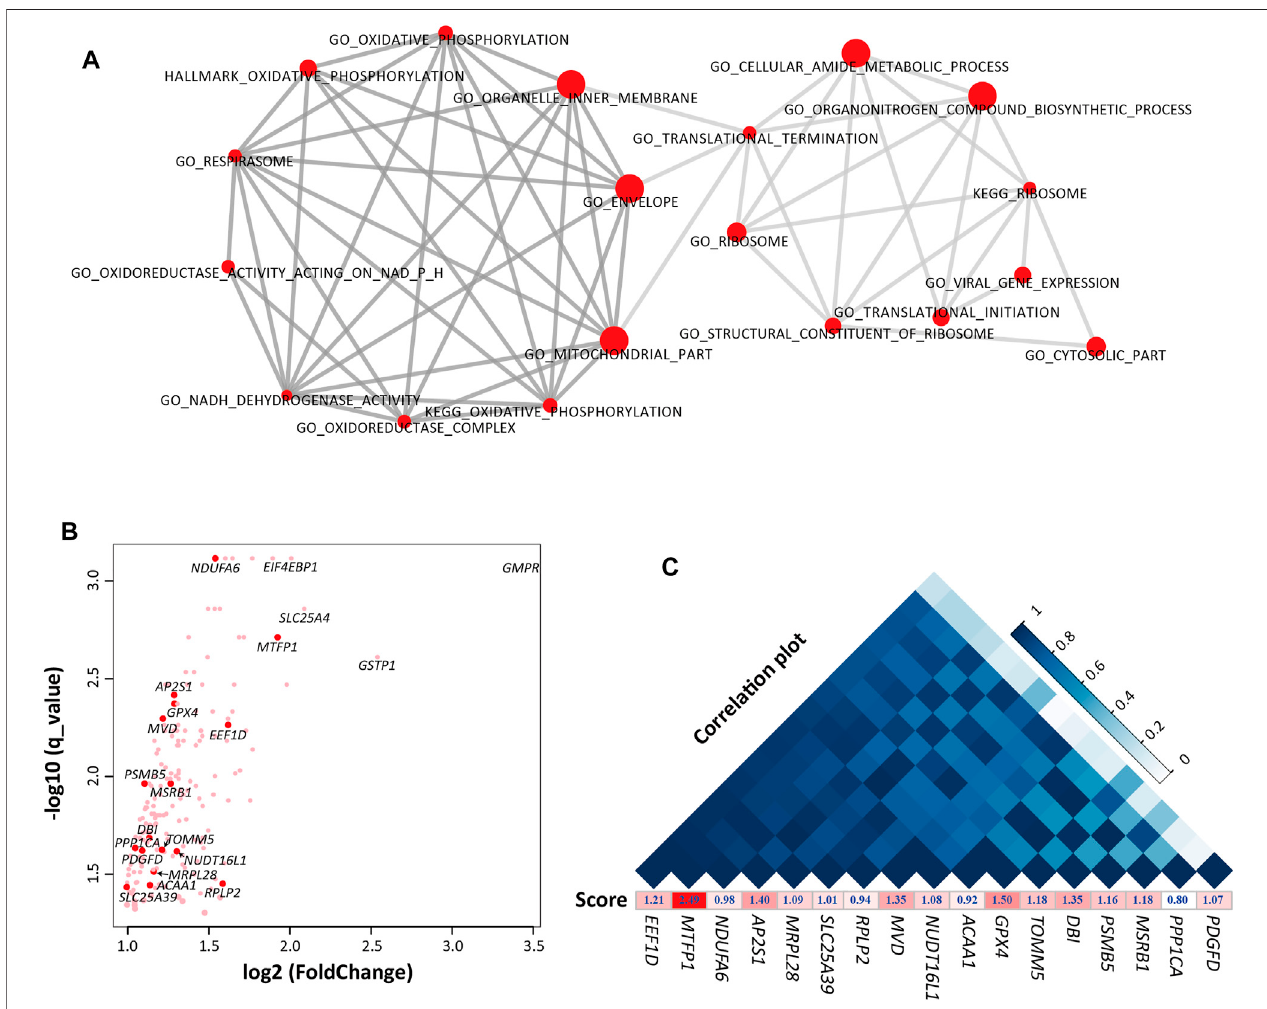
FIGURE3| ThegenesetsandgenesthatwereenrichedinE70comparedwithE70_SFKbyGeneSetEnrichmentAnalysis(GSEA). (A) Thetop10mostsigni fi cant genesetsineachfunctionalgroup.Left,energymetabolism-relatedgenesets.Right,regulationoftranscription-relatedgenesets. (B) Expressionfold-changesbetween E70 and E70_SFK and the corresponding q values for the genes enriched in the gene sets that were upregulated at E70 ( n = 183). The red data points indicate the 17 genes that have been previously reported. (C) An expression correlation plot (top) for the 17 previously reported genes according to their expression for E60, E70, E80, Fat and E70_SFK and ranked by their correlation coef fi cient. The enrichment score for each gene obtained using GSEA is also displayed below.